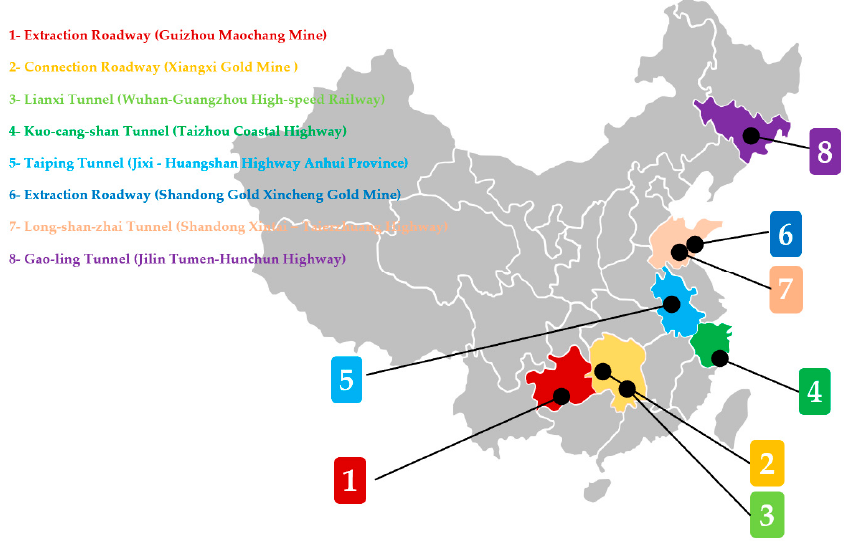
Figure 10. Tunneling sources of other SWB data.